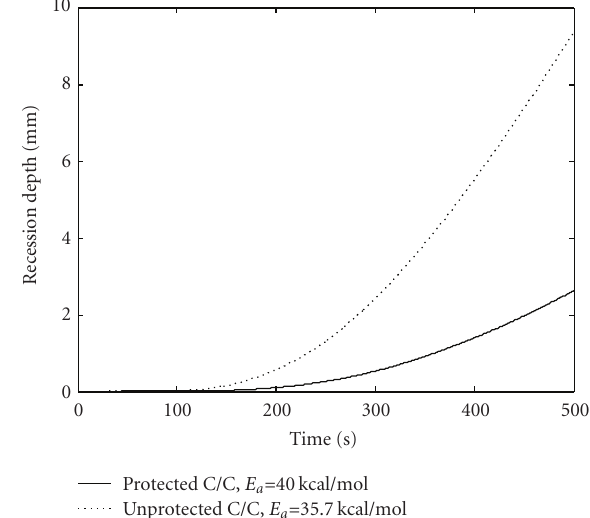
Figure 10: E ff ect of Oxidation protection at sea level, h = 0 .